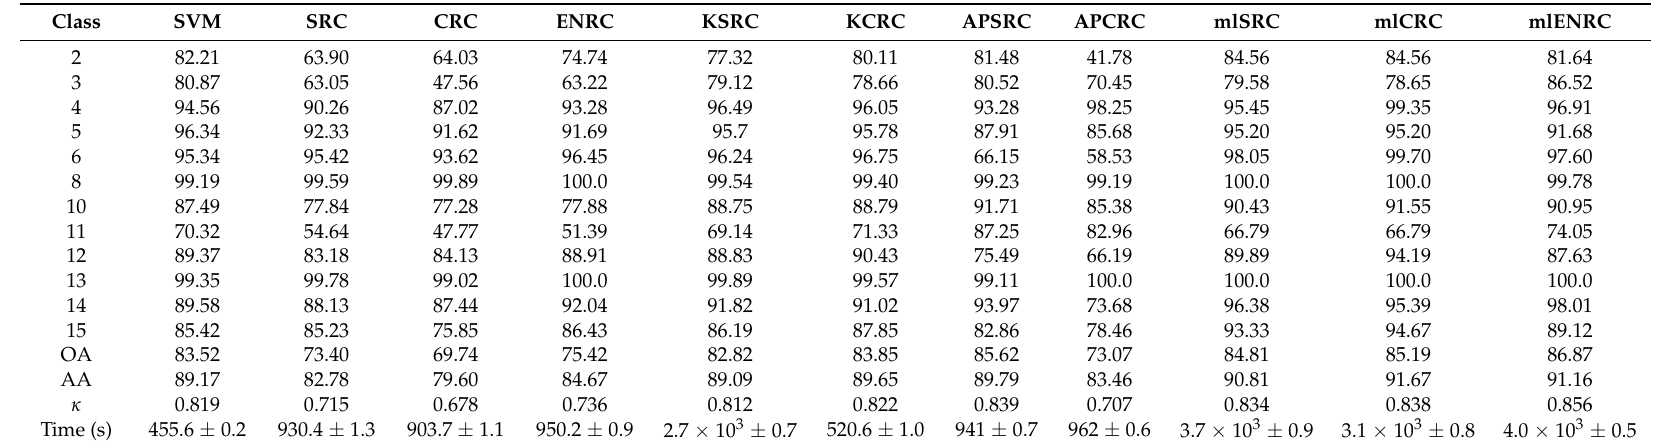
Table 4. Class-specific accuracy (%), overall (OA), average (AA), kappa ( κ ), as well as computational time in seconds with 120 training samples per class for the Indian Pines